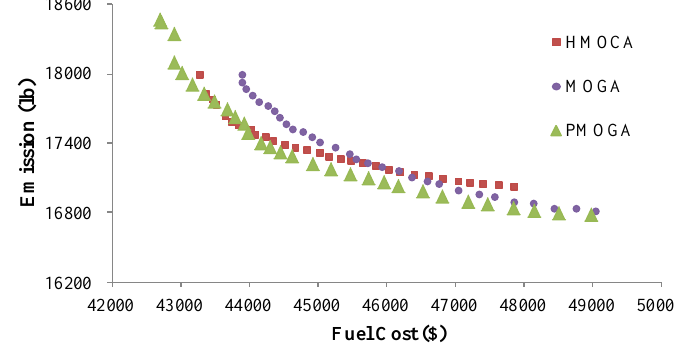
Figure 11. The optimal Pareto front by different algorithms for Case 3.